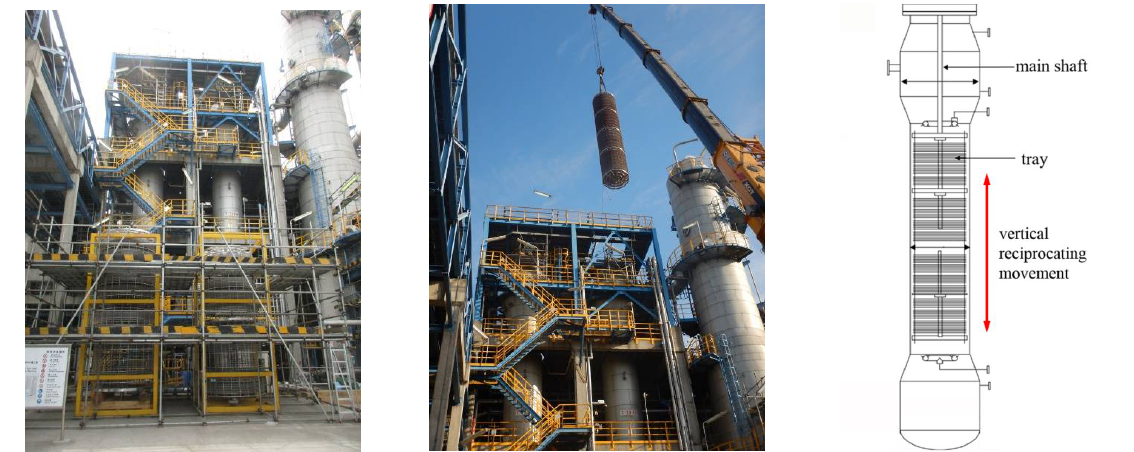
Figure 3. The main steps of C4 direct oxidation method to produce MMA.